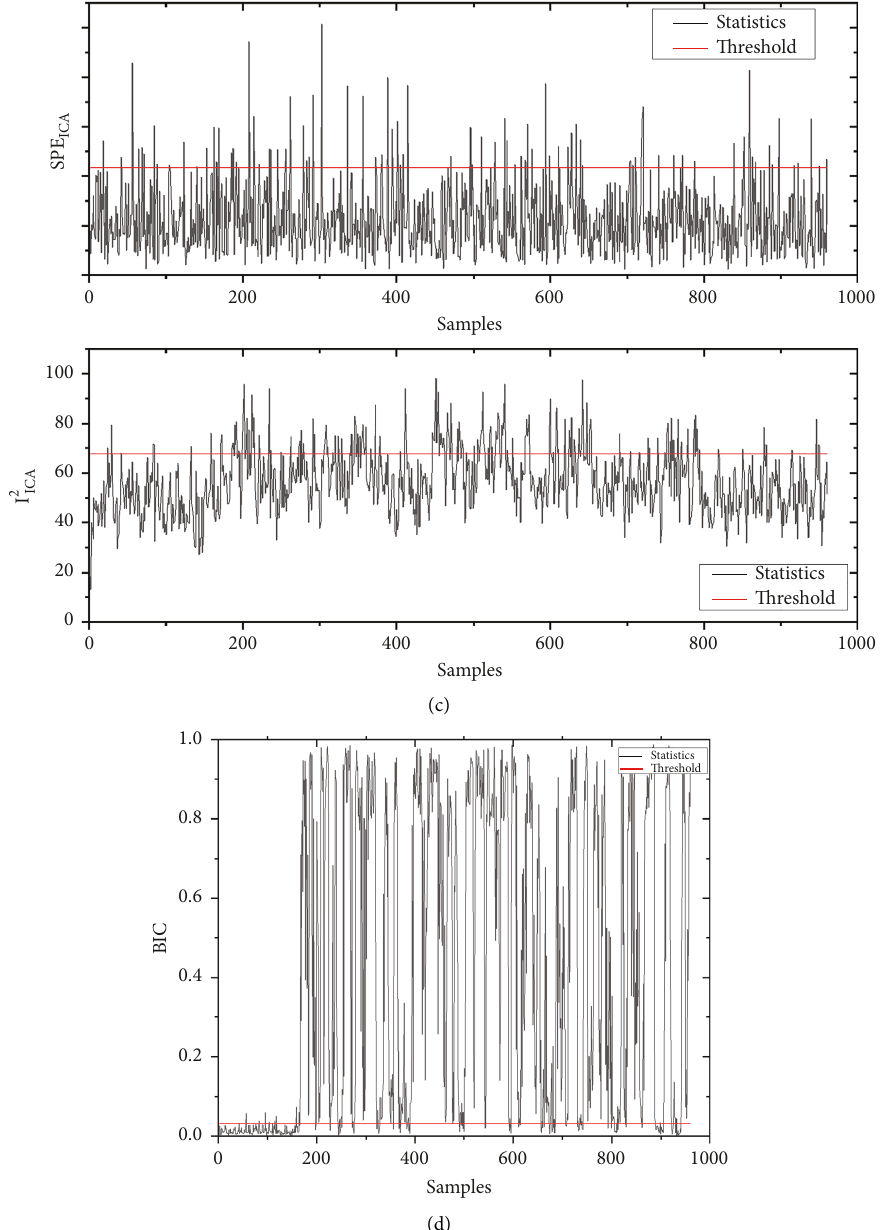
Figure 3: Monitoring results of fault 11 in the TE process: (a) PCA; (b) KPCA; (c) ICA; (d)